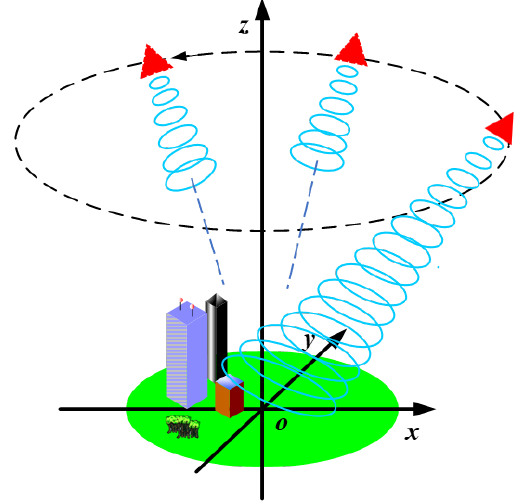
Figure 1. Circular SAR observation